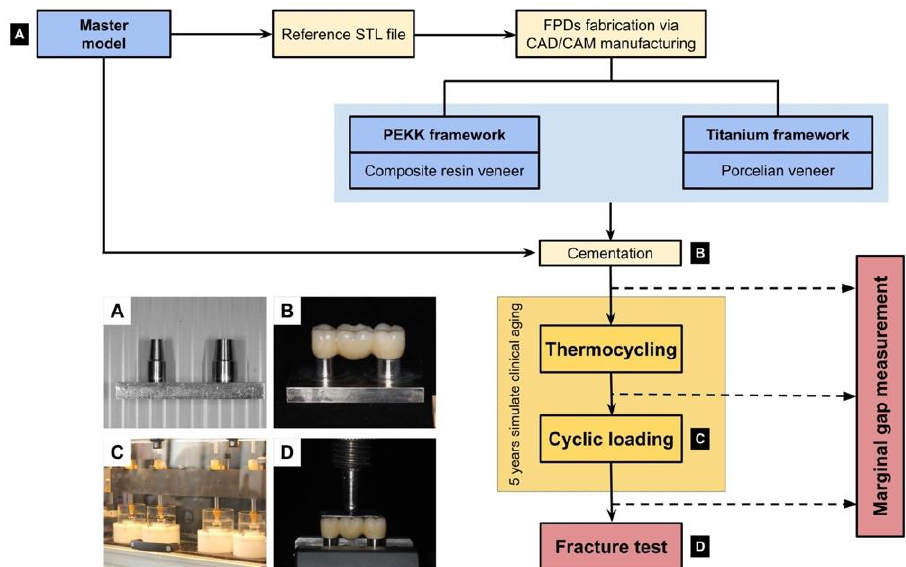
Figure 1. A brief experimental workflow of this study. The master models ( A ) were scanned, and a CAD/CAM manufacturing system was used for the fabrication of the PEKK and titanium frameworks. The FPDs were cemented to the models ( B ), then underwent simultaneous thermal cycling and mechanical loading ( C ) procedures to simulate 5 years of clinical service. Vertical gap measurements were performed before and after each artificial aging condition. Fracture load after aging was measured ( D